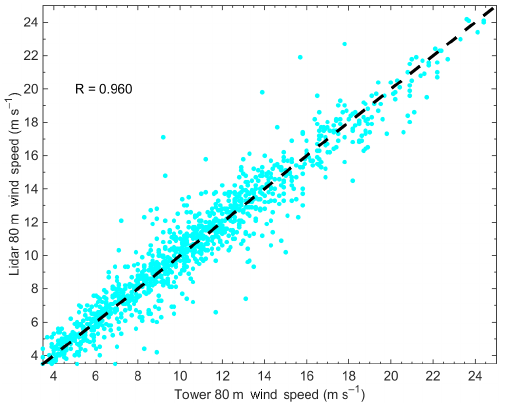
Figure 8. Lidar 80m wind speeds compared to tower 80m wind speeds filtered for wind speeds between 3.5 and 25.0ms − 1 , wind directions between 235 and 315 ◦ , and for normal turbine operation. Black dashed line represents a 1:1